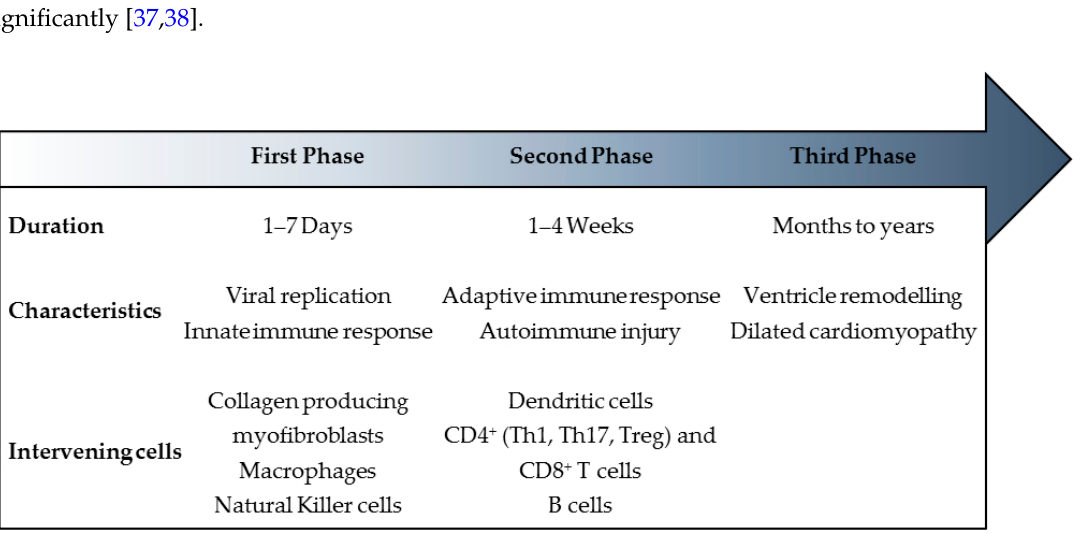
Figure 1. Myocarditis: A triphasic disease. In recent years, myocarditis has been set in a framework of three successive and distinct phases with undefined borders. For each phase, average duration (regarding the case of coxsackievirus-mediated myocarditis), characteristics and physiopathological intervenients are indicated. CD, cluster of differentiation; Th1, T helper 1; Th17, T helper 17; Treg, regulatory T.